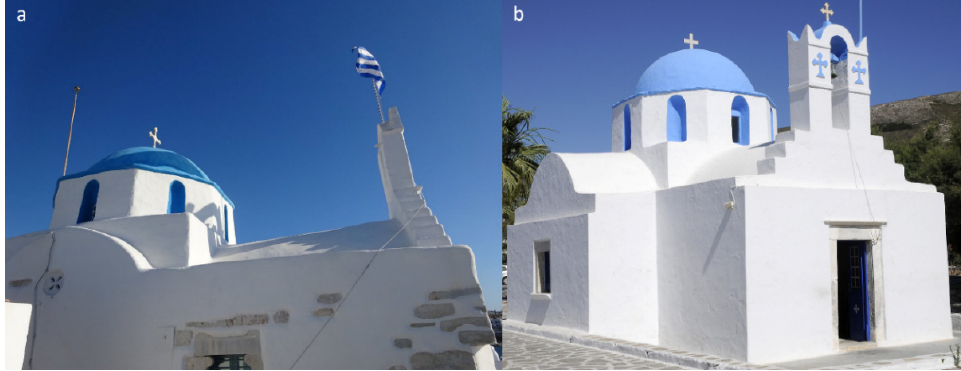
Figure 6. Representative examples of domed churches on Paros. ( a ). Single-aisled, Agios Konstanti- nos, Paroikia; ( b ). Free cross, Agios Nikolaos, Paroikia (photos by the